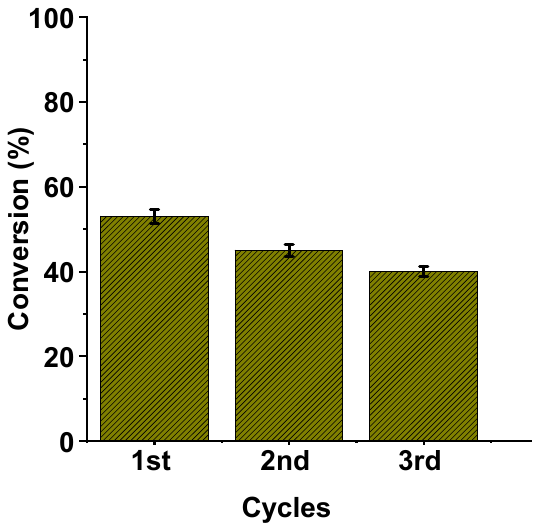
Figure 5. Recycling experiments of ND@ β NH-TPP p CF 3 -Cu(II) in the oxidation of cyclohexene. Data represent the mean ± standard error (n = 3).